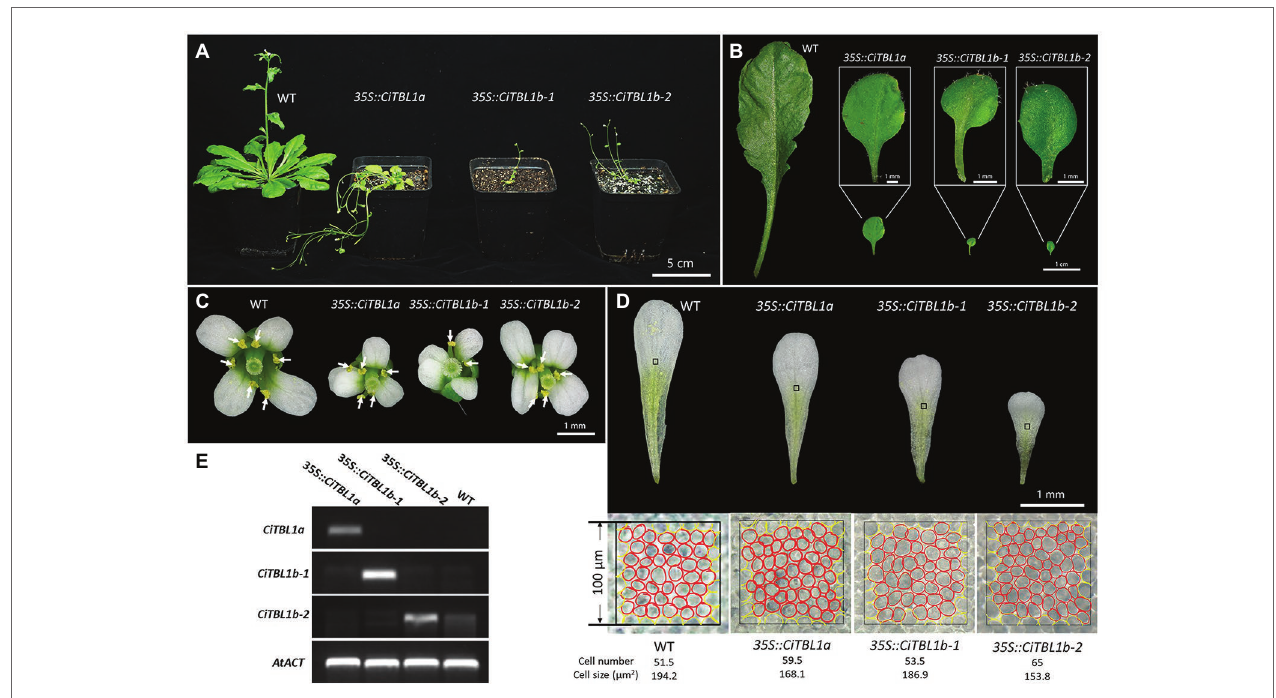
FIGURE 6 | Effects of ectopic expressions of the Canna CiTBL genes in Arabidopsis . Effect of overexpressing CiTBL1a , CiTBL1b-1 , and CiTBL1b-2 on Arabidopsis (A) vegetative growth, (B) leaf size and shape, (C) flower symmetry, and (D) petal size. (E) Semi-quantitative RT-PCR results showing strong expression of CiTBL1a , CiTBL1b-1 , and CiTBL1b-2 in the flowers of T2 transgenic plants. All the stamens in (C) are indicated with arrows. A red circle in (D) represents one cell, whereas a yellow circle counted for ½